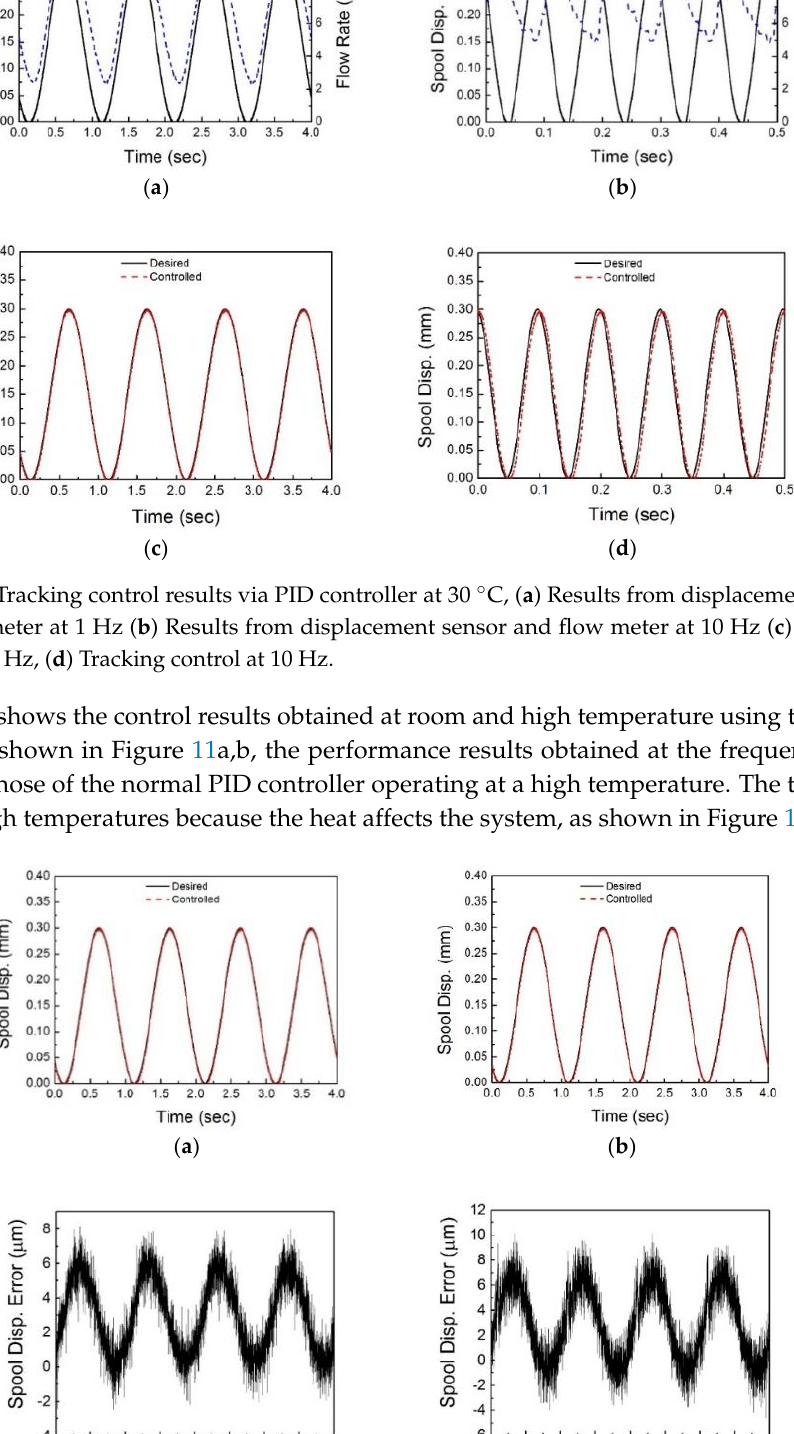
( b ) ( c ) Figure 12. Tracking control results with 200 Hz, (a) Tracking control result via PID controller at 30 °C, (b) Tracking control result via PID controller at 150 °C with same PID gains at 30 °C, (c) Tracking control result via fuzzy PID controller at 150 °C .